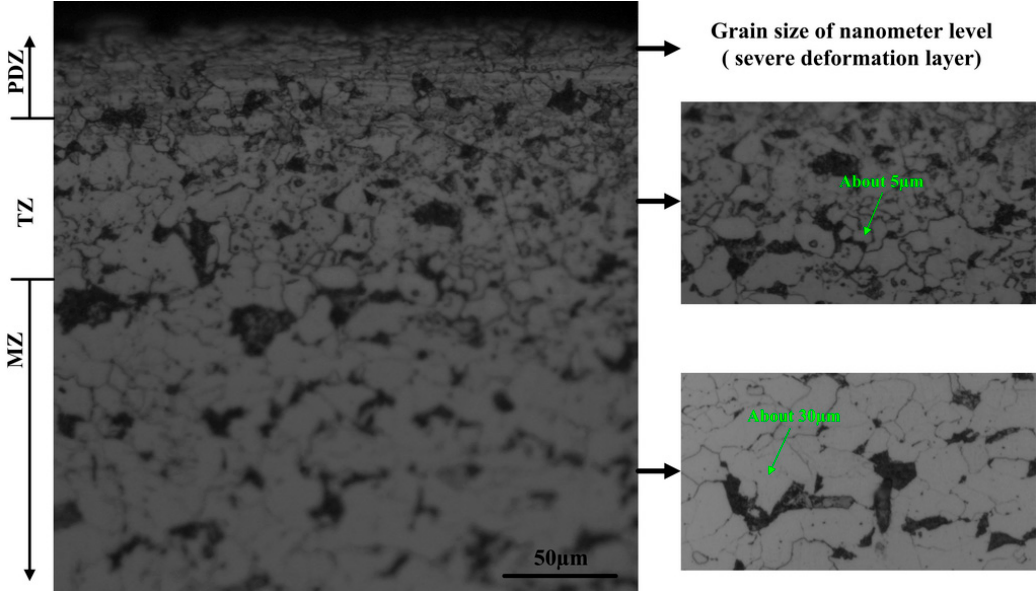
Figure 3. Microstructure and deformation layer after Ultrasonic peening treatment (UPT) (PDZ: Plastic deformation zone; TZ: Transition zone; MZ: Matrix zone).